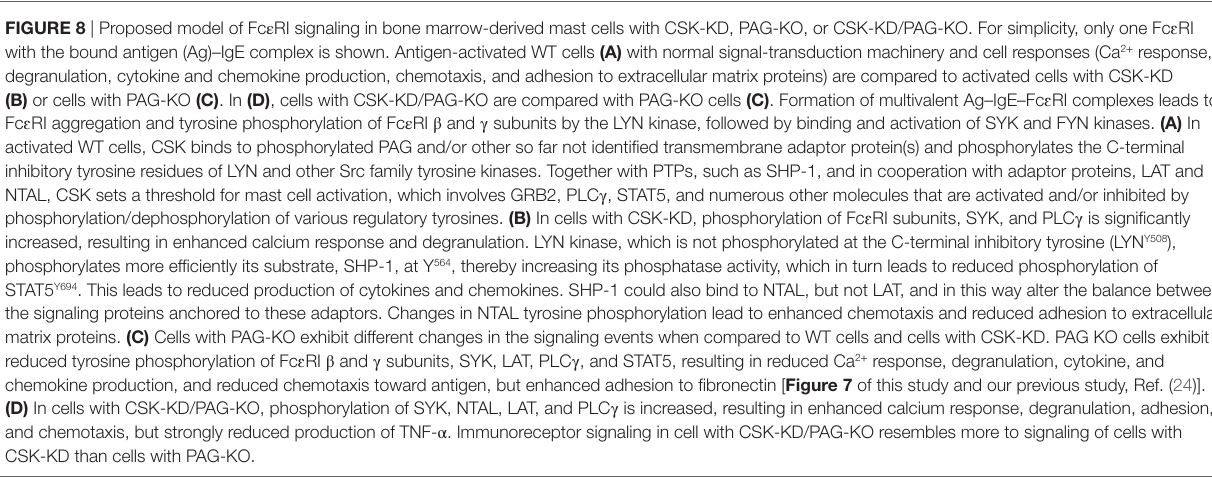
FigUre 8 | Proposed model of Fc ε RI signaling in bone marrow-derived mast cells with CSK-KD, PAG-KO, or CSK-KD/PAG-KO. For simplicity, only one Fc ɛ RI with the bound antigen (Ag)–IgE complex is shown. Antigen-activated WT cells (a) with normal signal-transduction machinery and cell responses (Ca 2 + response, degranulation, cytokine and chemokine production, chemotaxis, and adhesion to extracellular matrix proteins) are compared to activated cells with CSK-KD (B) or cells with PAG-KO (c) . In (D) , cells with CSK-KD/PAG-KO are compared with PAG-KO cells (c) . Formation of multivalent Ag–IgE–Fc ɛ RI complexes leads to Fc ɛ RI aggregation and tyrosine phosphorylation of Fc ε RI β and γ subunits by the LYN kinase, followed by binding and activation of SYK and FYN kinases. (a) In activated WT cells, CSK binds to phosphorylated PAG and/or other so far not identified transmembrane adaptor protein(s) and phosphorylates the C-terminal inhibitory tyrosine residues of LYN and other Src family tyrosine kinases. Together with PTPs, such as SHP-1, and in cooperation with adaptor proteins, LAT and NTAL, CSK sets a threshold for mast cell activation, which involves GRB2, PLC γ , STAT5, and numerous other molecules that are activated and/or inhibited by phosphorylation/dephosphorylation of various regulatory tyrosines. (B) In cells with CSK-KD, phosphorylation of Fc ɛ RI subunits, SYK, and PLC γ is significantly increased, resulting in enhanced calcium response and degranulation. LYN kinase, which is not phosphorylated at the C-terminal inhibitory tyrosine (LYN Y508 ), phosphorylates more efficiently its substrate, SHP-1, at Y 564 , thereby increasing its phosphatase activity, which in turn leads to reduced phosphorylation of STAT5 Y694 . This leads to reduced production of cytokines and chemokines. SHP-1 could also bind to NTAL, but not LAT, and in this way alter the balance between the signaling proteins anchored to these adaptors. Changes in NTAL tyrosine phosphorylation lead to enhanced chemotaxis and reduced adhesion to extracellular matrix proteins. (c) Cells with PAG-KO exhibit different changes in the signaling events when compared to WT cells and cells with CSK-KD. PAG KO cells exhibit reduced tyrosine phosphorylation of Fc ɛ RI β and γ subunits, SYK, LAT, PLC γ , and STAT5, resulting in reduced Ca 2 + response, degranulation, cytokine, and chemokine production, and reduced chemotaxis toward antigen, but enhanced adhesion to fibronectin [ Figure 7 of this study and our previous study, Ref. (24)]. (D) In cells with CSK-KD/PAG-KO, phosphorylation of SYK, NTAL, LAT, and PLC γ is increased, resulting in enhanced calcium response, degranulation, adhesion, and chemotaxis, but strongly reduced production of TNF- α . Immunoreceptor signaling in cell with CSK-KD/PAG-KO resembles more to signaling of cells with CSK-KD than cells with